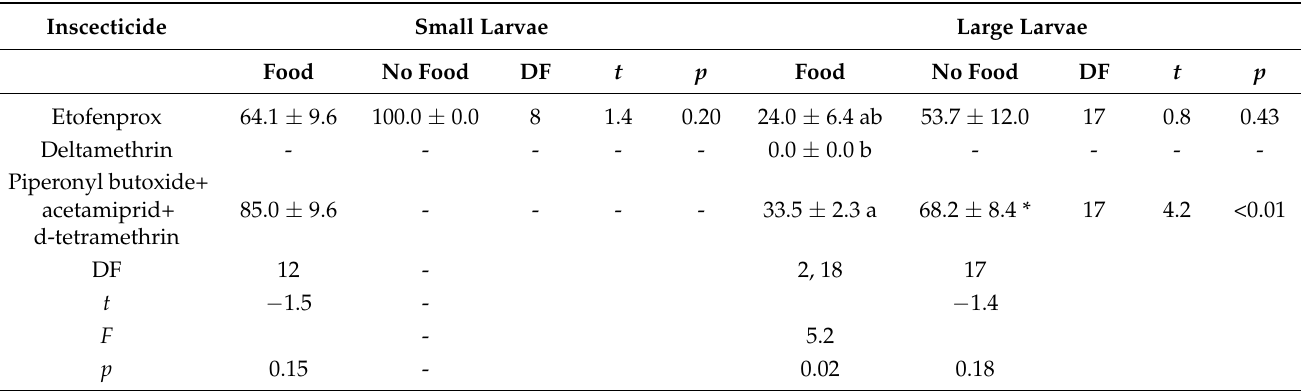
Table 5. Mean long-term mortality (% ± SE) of Alphitobius diaperinus small and large larvae exposed for 7 days on untreated concrete dishes, with or without food, after 7 days of exposure on concrete dishes treated with etofenprox, deltamethrin and piperonyl butoxide+acetamiprid+d-tetramethrin. Within each row, asterisks indicate significant differences (two-tailed t -test at p = 0.05). Within each column, means that are followed by the same lower-case letter are not significantly different (Tukey- Kramer HSD test at p = 0.05). Where no letters or no asterisks exist, no significant differences were recorded. Where dashes exist, no analysis was